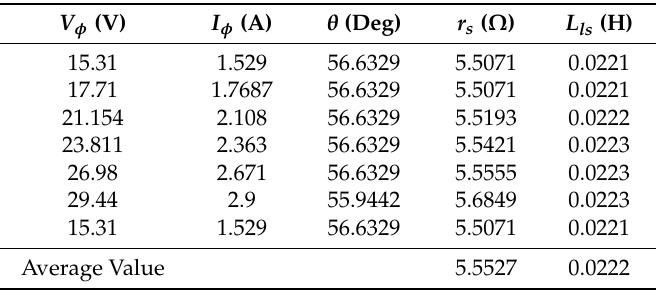
Table 3. Single phase AC without rotor test Results.